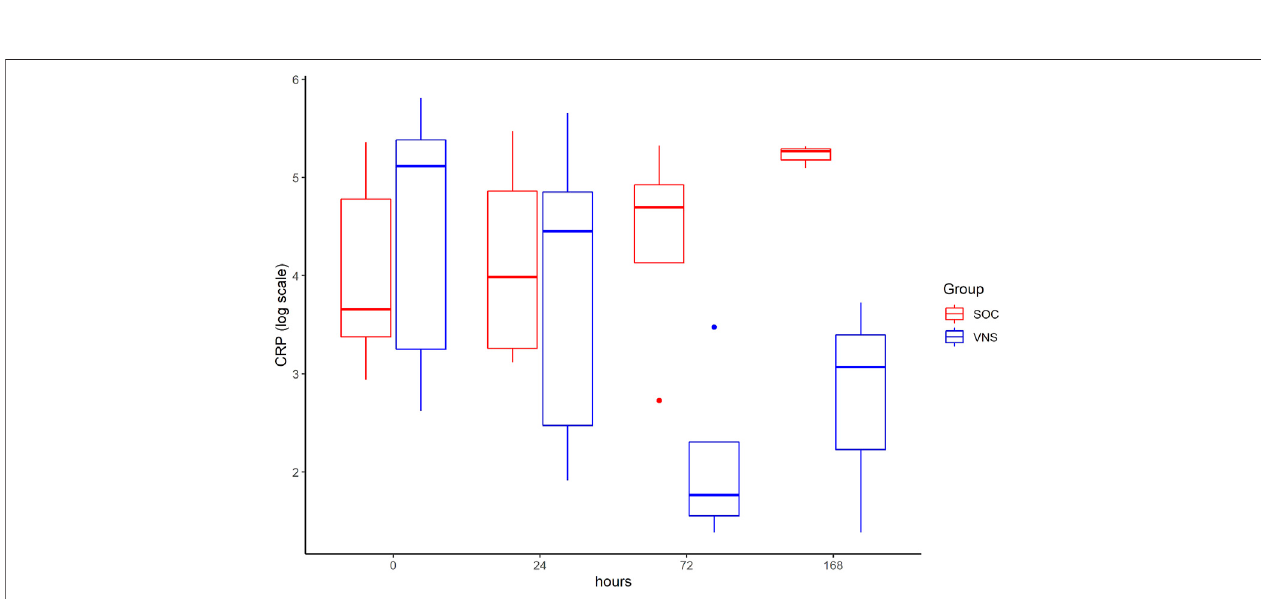
FIGURE 8 | Median CRP level with Interquartile Range of patients receiving auricular Vagus Stimulation (VNS = blue) and patients only receiving Standard of Care (SOC = red) after 0, 24, 72, and 168 h of study inclusion.